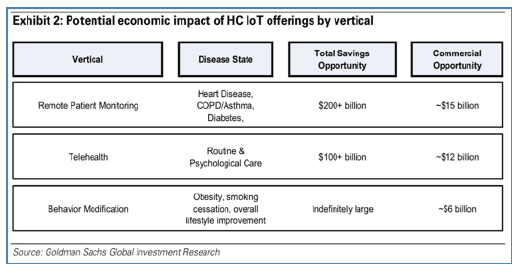
Figure 2. The potential impact of IoT in